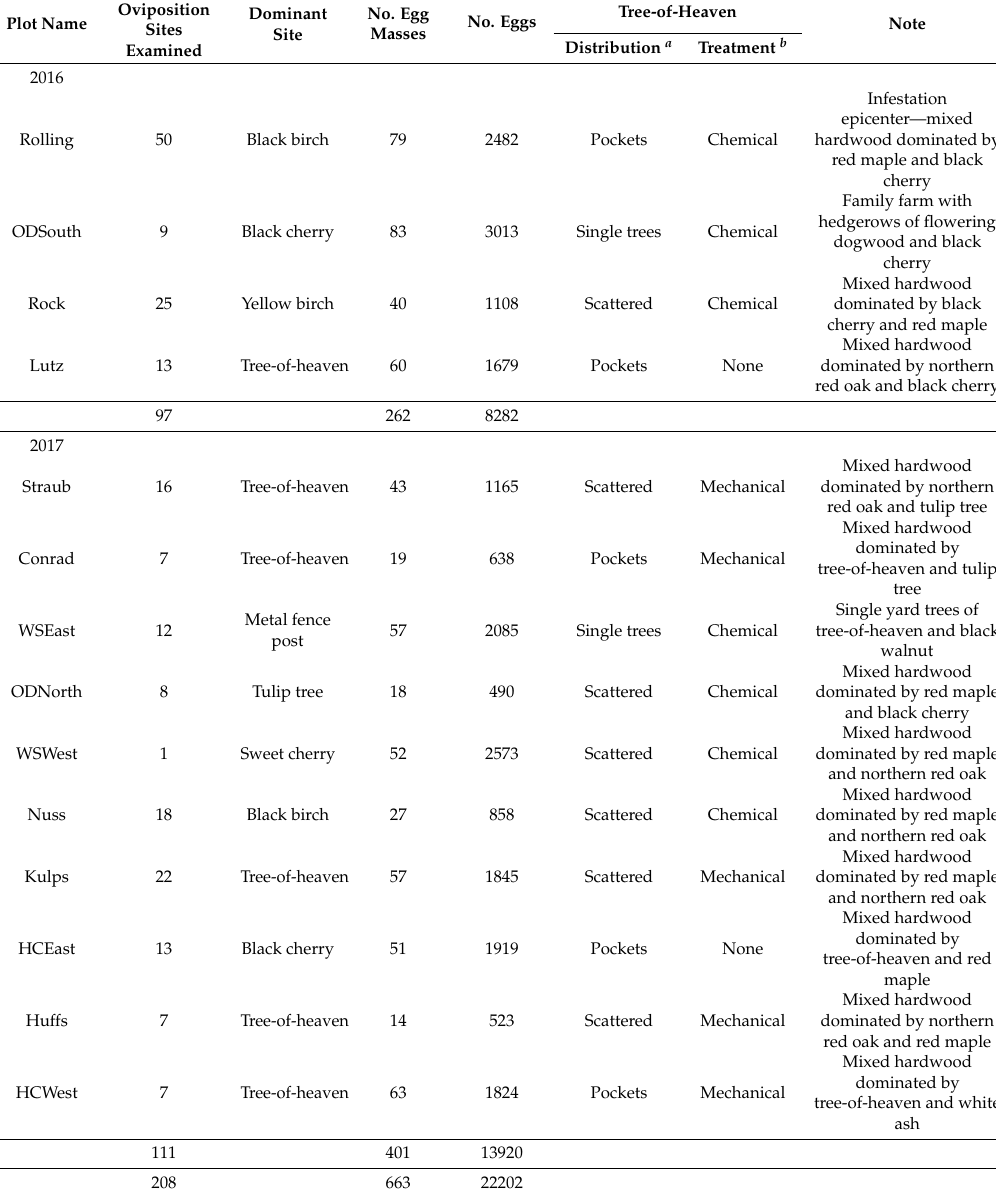
Table 1. L. delicatula egg collection for natural enemy studies in Pennsylvania in